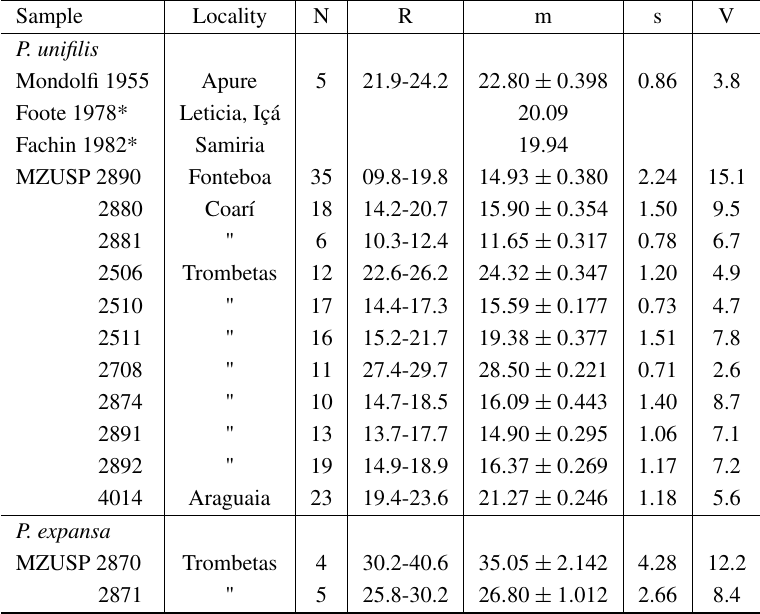
Podocnemis . Statistics of the distributions of frequencies of egg